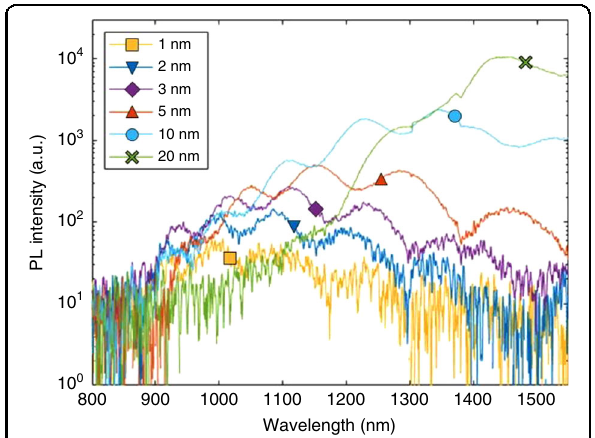
Fig. 1 Room temperature PL from N-polar InN QDs grown by MOCVD with varying nominal thicknesses. Increasing intensity and red-shifted emission seen as nominal thickness increases. Reprinted from Reilly et al., Appl. Phys. Lett. 114 , 241103 (2019) with permission of